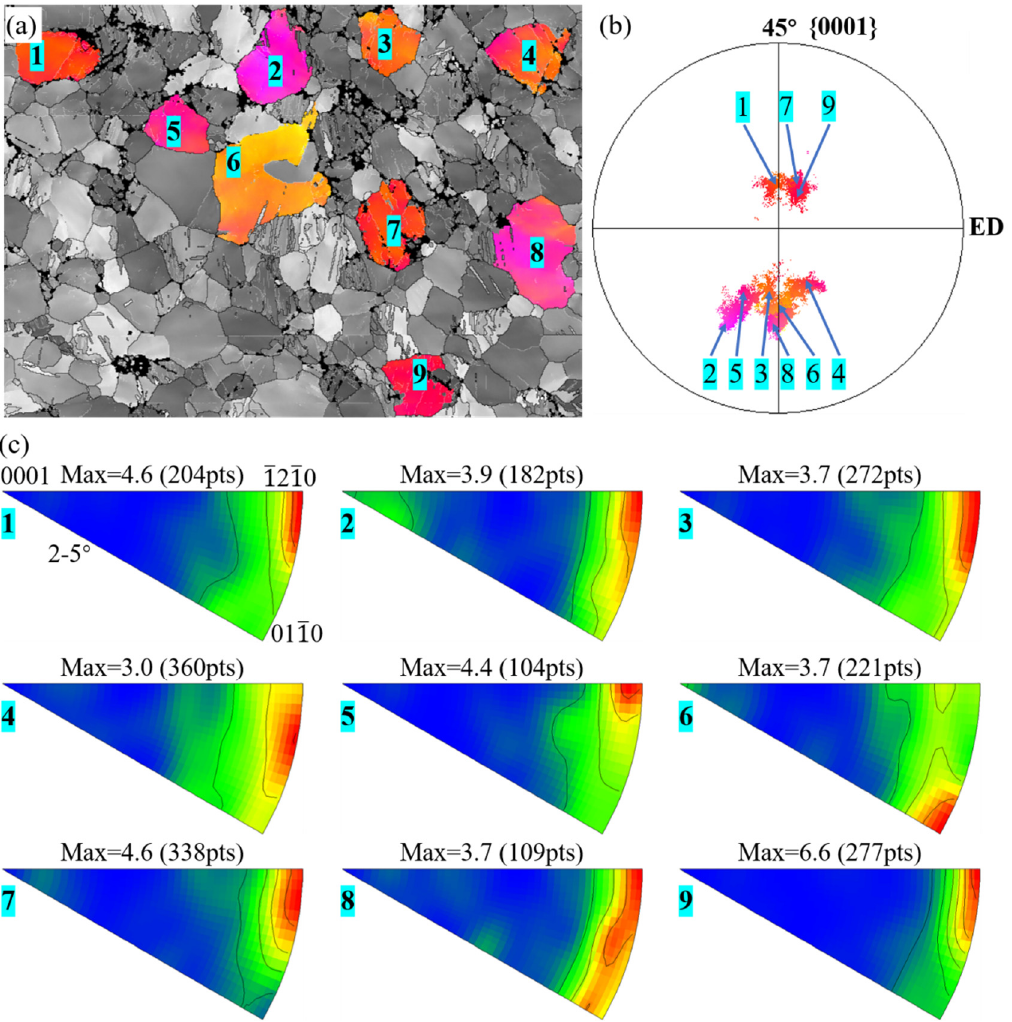
Figure 10. IGMA analysis of basal slip in the bent 45° bar: ( a ) inverse pole fi gure maps of the selected grains; ( b ) pole fi gures of the selected grains; ( c ) calculated IGMA of the selected grains. grains; ( b ) pole figures of the selected grains; ( c ) calculated IGMA of the selected